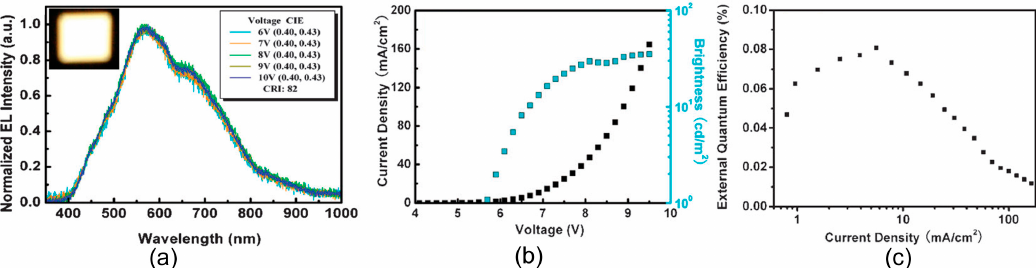
Figure 9. ( a ) Normalized electroluminescence (EL) spectra of direct architecture LEDs at applied bias voltages: the inset is a photograph of a white emission of our device (16 mm 2 ) operating at 9 V. ( b ) J – L – V characteristics of white OLEDs (WOLEDs). ( c ) The dependence of external quantum efficiency (EQE) on J. Reproduced with permission from [73], copyright 2011 The Royal Society of Chemistry.